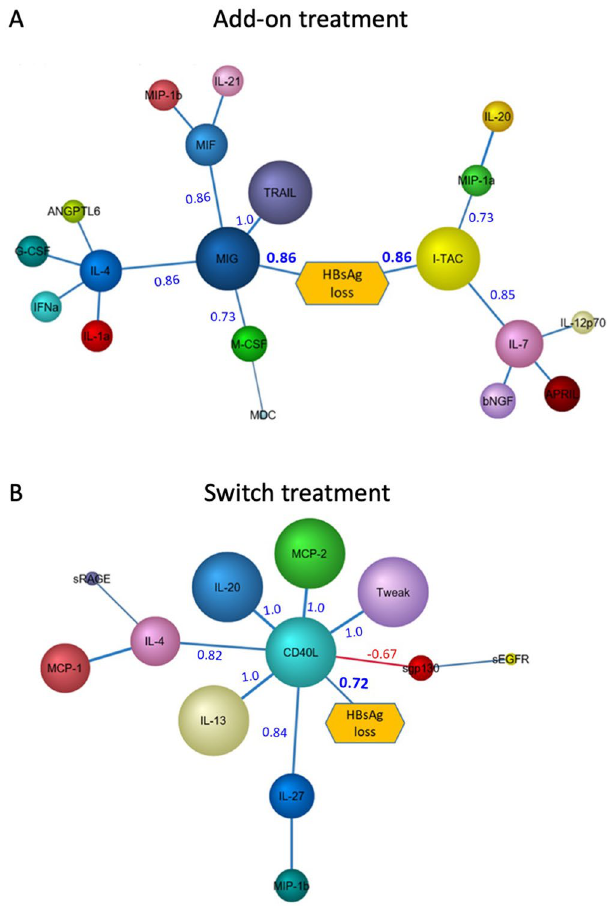
Figure 5. Bayesian network analysis of cytokines at the time-point before loss of HBsAg (T2) in the add-on and switch arms of treatment. Bayesian network of cytokines contributing to loss of HBsAg in ( A ) add-on treatment and ( B ) switch treatment. Size of the nodes indicate relative probabilistic contribution of each node to the loss of HBsAg and the colour of the arcs indicate positive (blue) or negative (red) Pearson correlation between adjoining nodes. The Pearson correlation values for the nodes are as indicated. Network and figures were generated using BayesiaLab software (version 8) (https:// www. bayes ia.